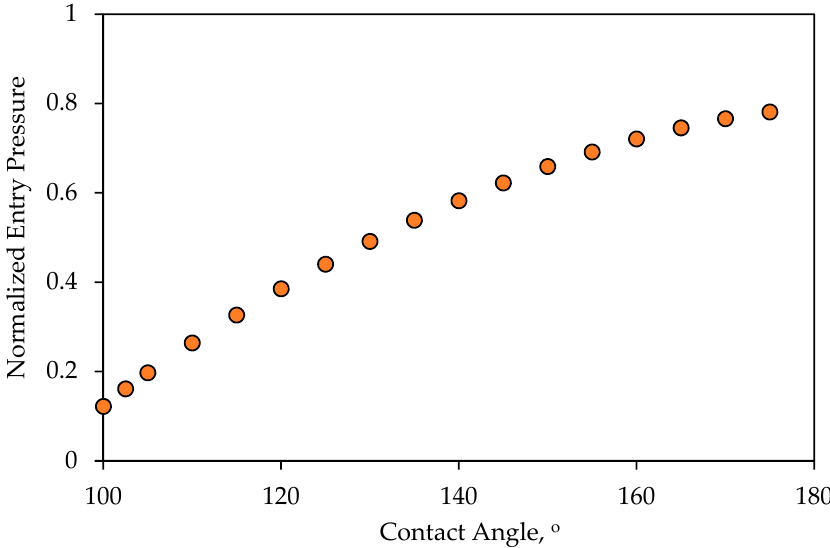
Figure 5. Normalized entry pressure variations with the contact angle (which was assumed to be the same at the surface of the membrane and inside the pore) for the case in which r d = 40 µ m, r p = 2 µ m, and σ = 0.035 N/m. The pressure value was normalized relative to the capillary pressure of the interface inside the pore, i.e., 2 σ cos ϑ 2 / r p .